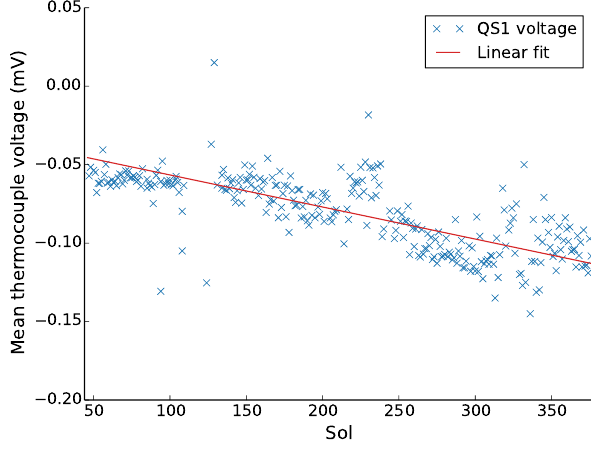
Figure 11. Bias correction of QS1.